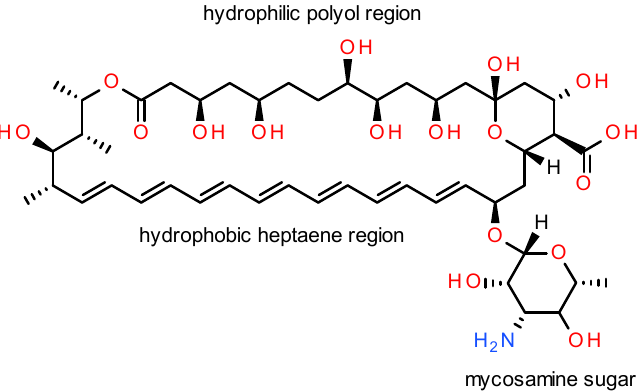
Figure 1. Chemical structure of amphotericin B.